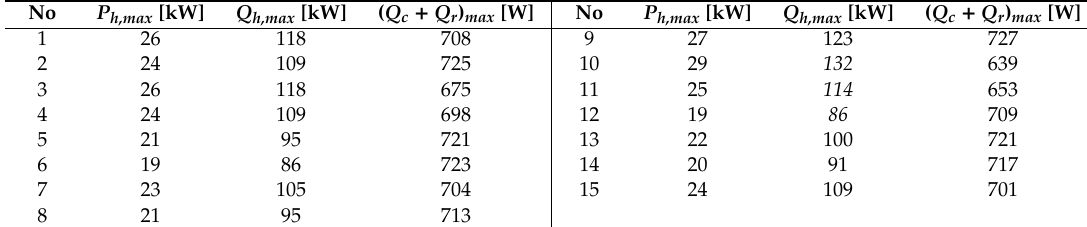
Figure 4. Simulation conditions: ( a ) two types of load curves and photovoltaics (PV) production profiles in the distribution network, ( b ) ambient temperature T xt , ( c ) locational marginal pricing (LMP) and time-of-use (TOU) price, and ( d ) internal heat gains Q ct + Q rt for building rooms. Table 2. Power capacity and cooling rate of the HVAC systems and maximum heat gain per building room.